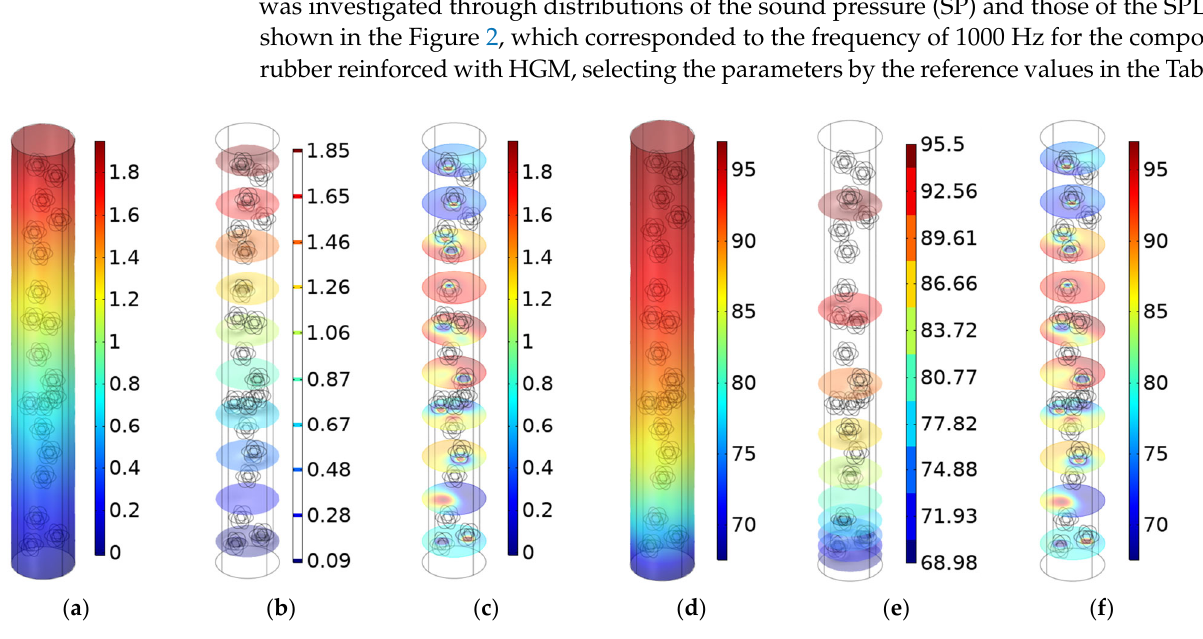
Figure 2. Sound insulation mechanism of the composite rubber reinforced with HGM. ( a ) Distribution of the SP; ( b ) the isosurfaces of the SP; ( c ) the sectional surfaces of the SP; ( d ) distribution of the SPL; ( e ) the isosurfaces of the SPL; ( f ) the sectional surfaces of the SPL. It could be found that both the SP and SPL decreased along the thickness direction.